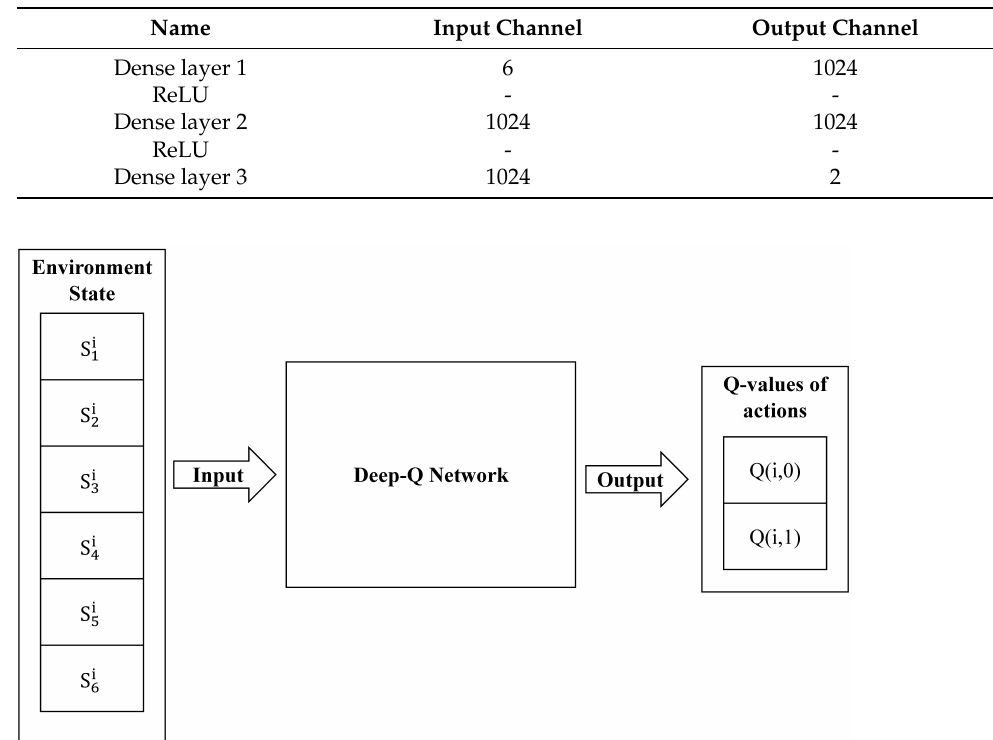
Table 1. Architecture of the neural network in the DQN framework.